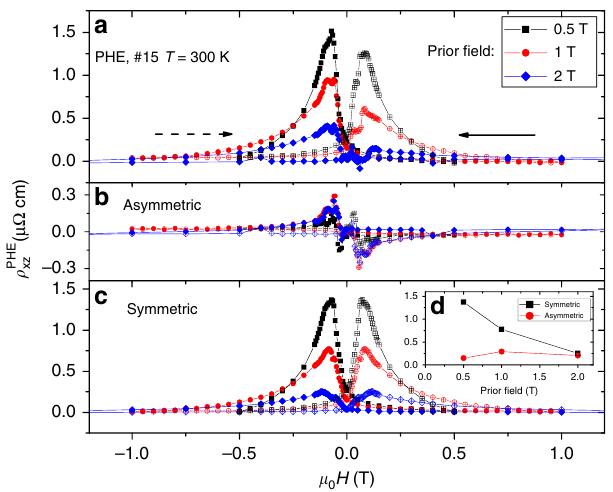
Fig. 5 Evolution of the PHE signal with the amplitude of the prior magnetic fi eld. a Planar Hall effect measured after cycling and rotating the magnetic fi eld at 0.5, 1, and 2T. b , c Asymmetrical and symmetrical components of planar Hall effect, extracted from ( a ). Inset in ( c ) shows the evolution of the magnitudes of the two components. The symmetric component steadily decreases with the increasing prior magnetic fi eld, but the asymmetric component does not. The closed and open symbols refer to opposite fi eld sweep orientations, marked by solid and dotted arrows shown in ( a